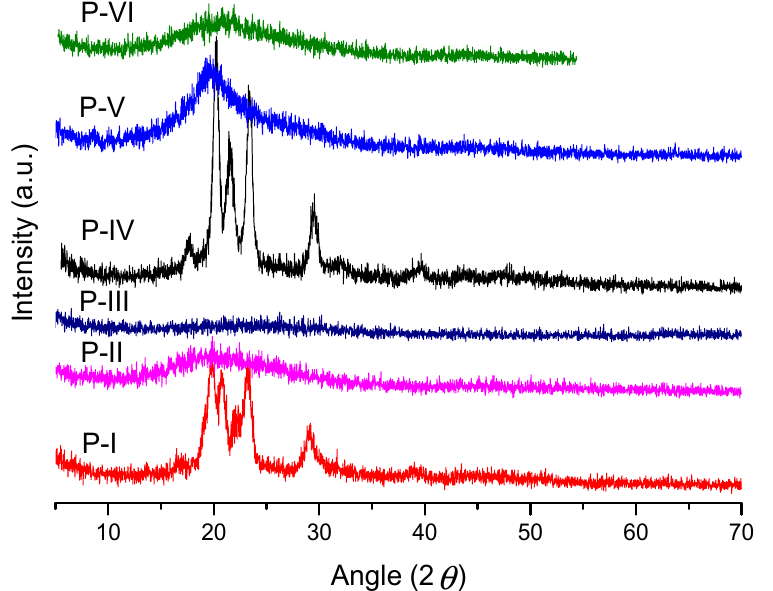
Figure 8. Powder XRD of polyazomethine-synthesized aromatic bis-aldehyde monomers 3a, 3b, and 3c .